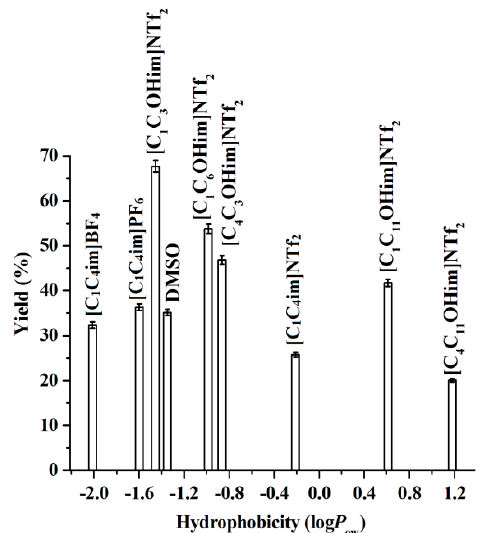
Figure 1. The correlation of the hydrophobicity of solvents used in this work and the warfarin yield. Reaction conditions: BA, 1.0 mmol, water, 0.1 mL, reaction time, 96 h, temperature, 45 °C, lipase, 30 mg, 4-HC, 0.5 mmol, [C 1 C 3 OHim]NTf 2 , 2.0 g.